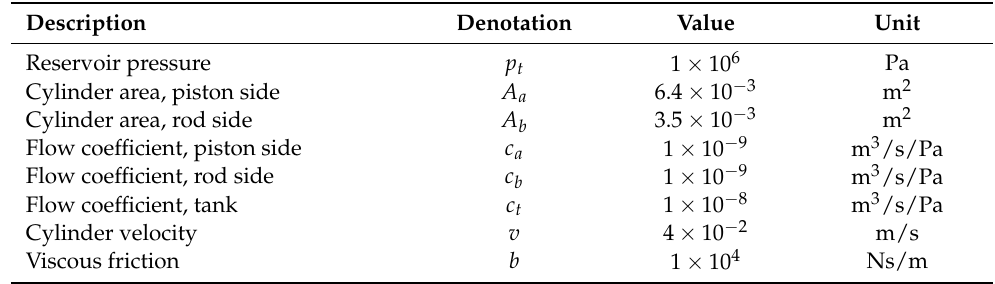
Table 1. Parameter values.